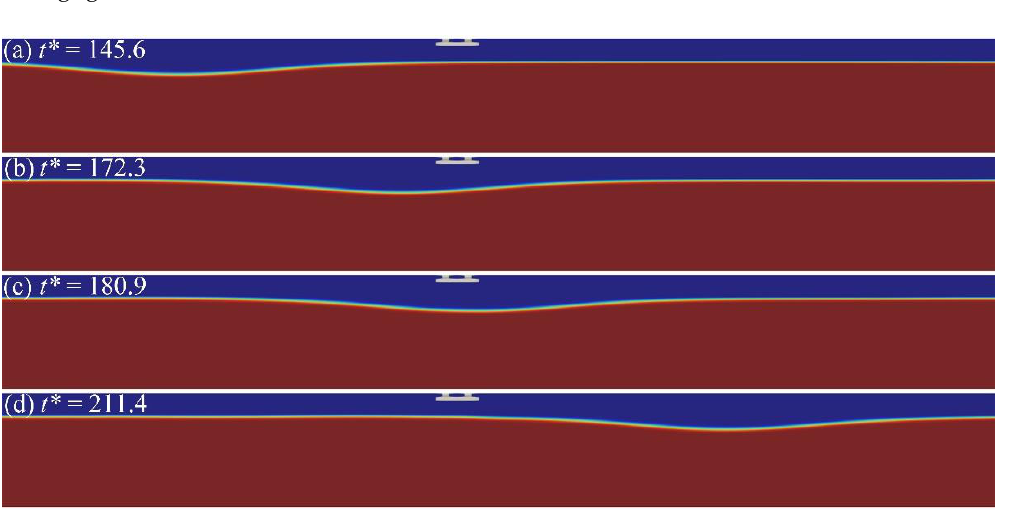
Figure 5. The evolution of the ISW profile for Case A2. t* is the dimensionless time.